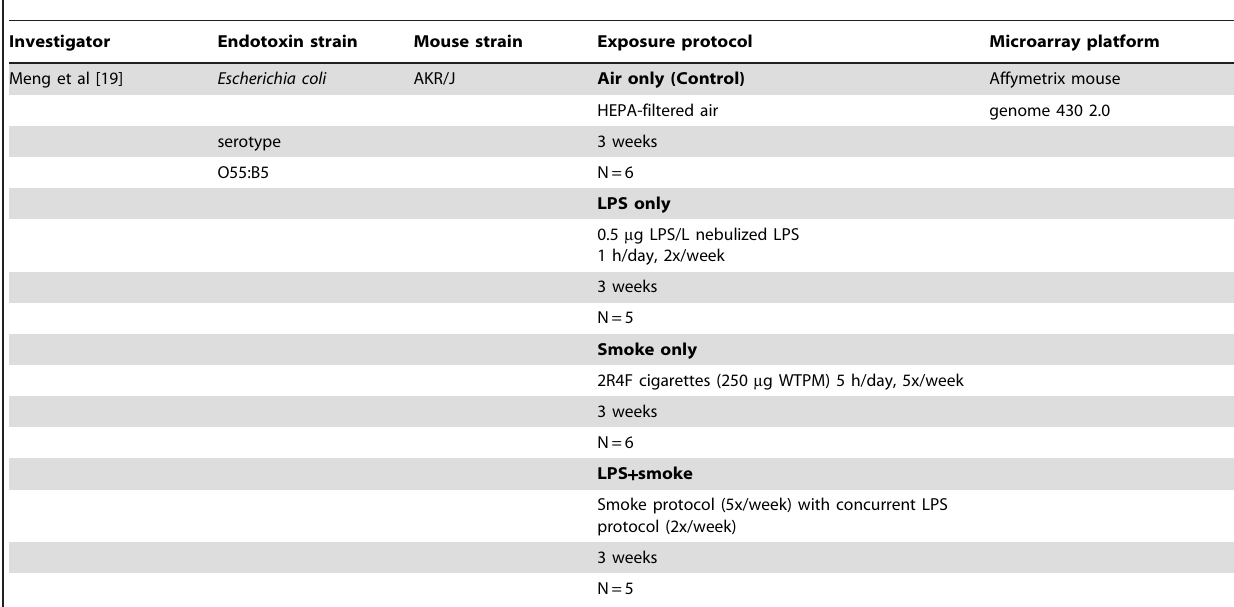
Table 4. Description of exposure protocol used in comparing endotoxin, cigarette smoke, and endotoxin plus cigarette smoke exposed mice.